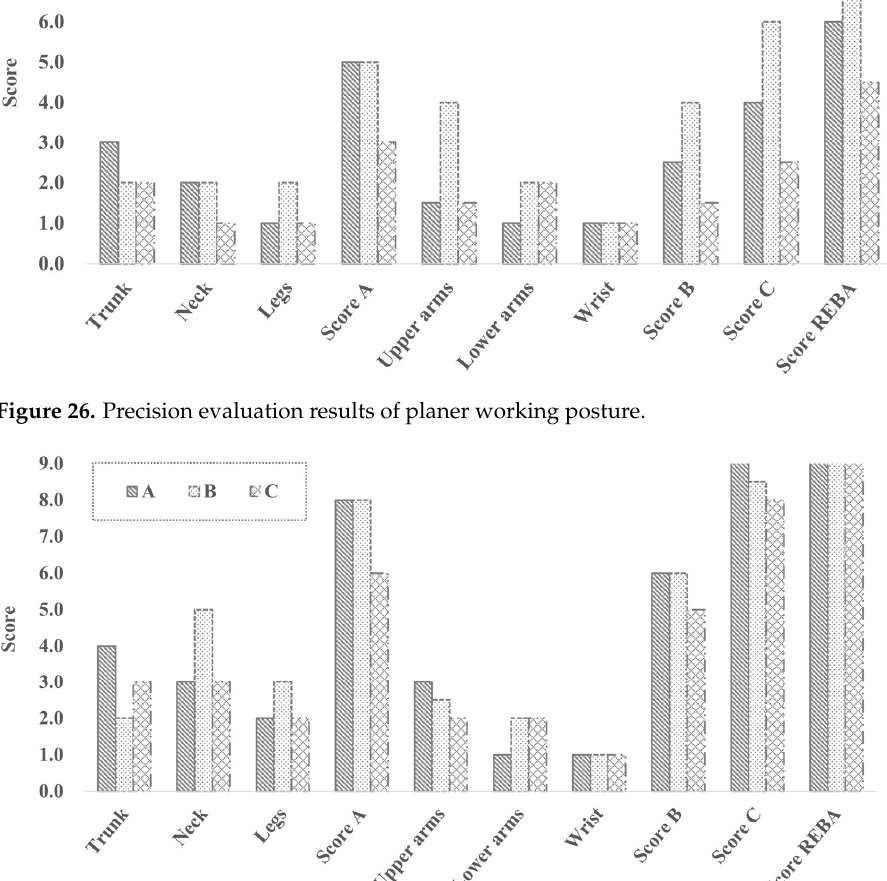
Figure 26. Precision evaluation results of planer working posture.